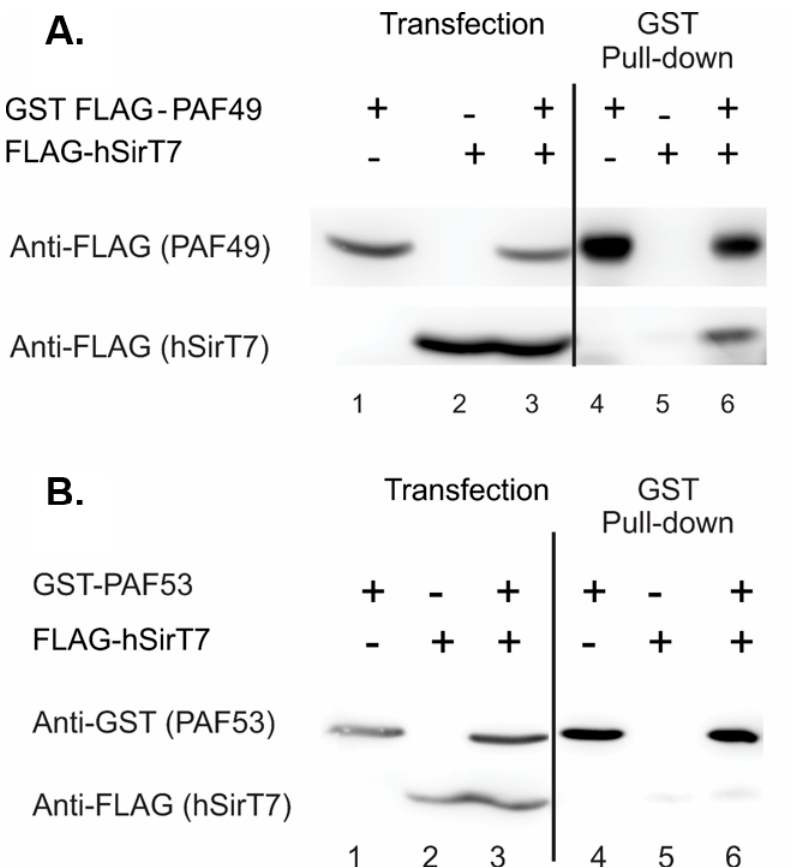
Figure 6. SIRT7 interacts with PAF49 ( A ), but not with PAF53 ( B ). HEK293 cells were transfected with vectors expressing the indicated proteins. Forty-eight hours following transfection, cell lysates were prepared, and the ectopically expressed proteins subjected to affinity purification (GSH). The input (10%) and the proteins that bind to the affinity matrix were analyzed by SDS-PAGE and Western blotting, as described [9].